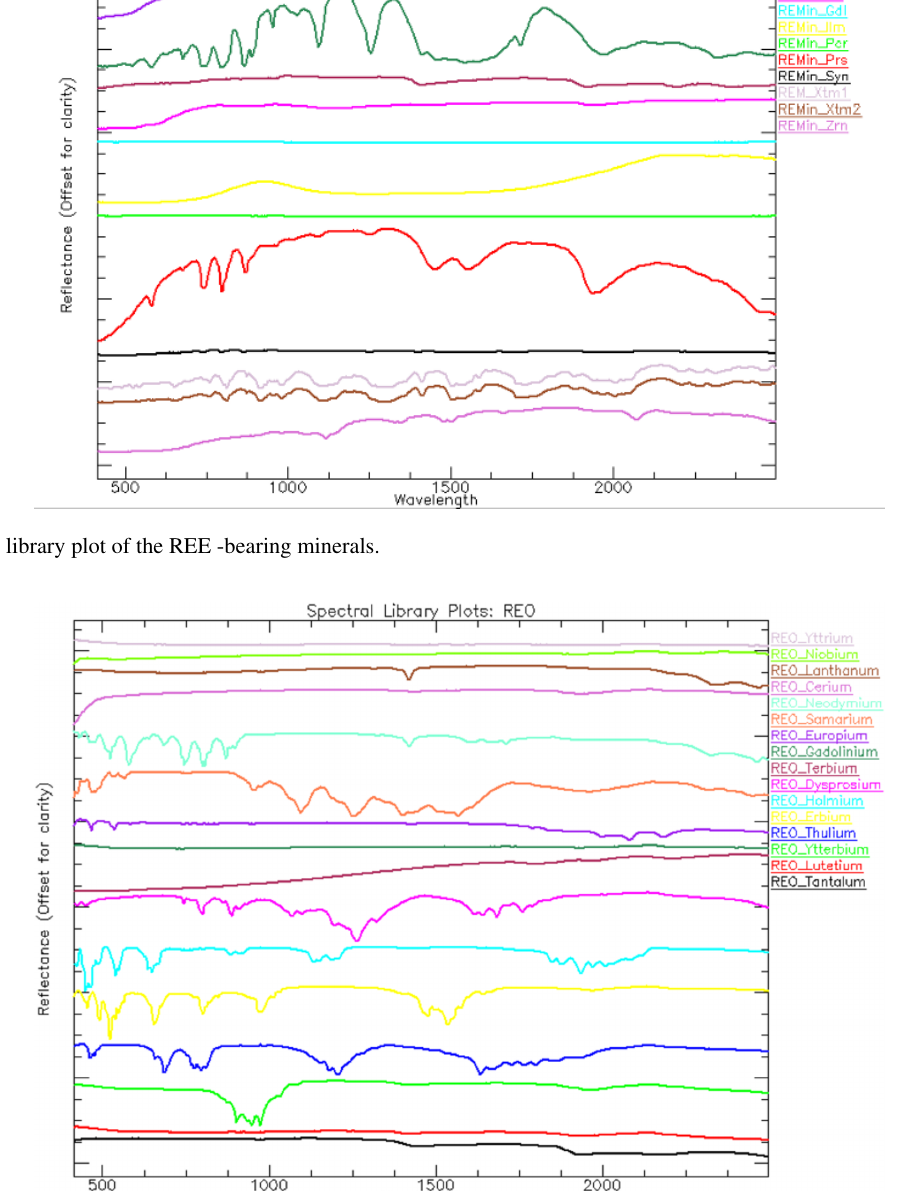
associated analysis method, type and internal BVM analysis codes can be found in the technical report of the Apliki mine surface sample data (Koerting et al.,